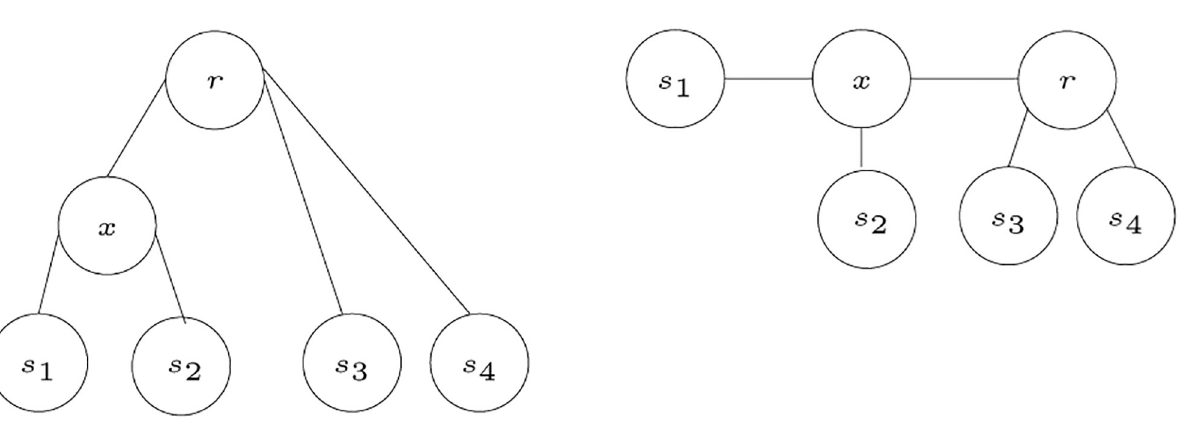
Fig 22. An example of how the poset corresponding to s 1 is